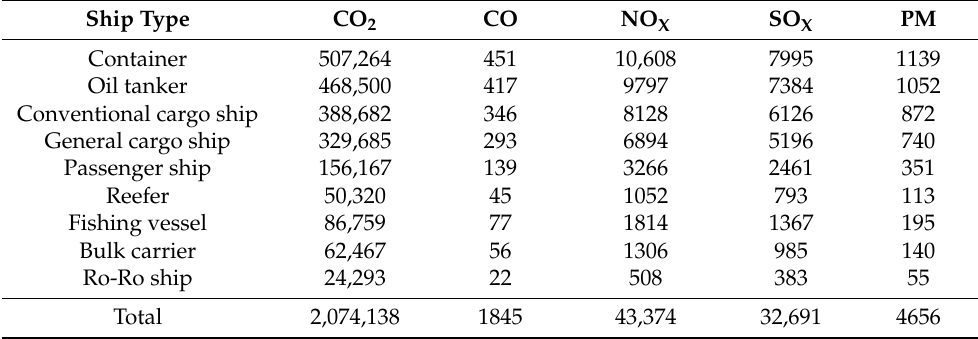
Table 9. Marine gas emission inventory from different ship types in BP in